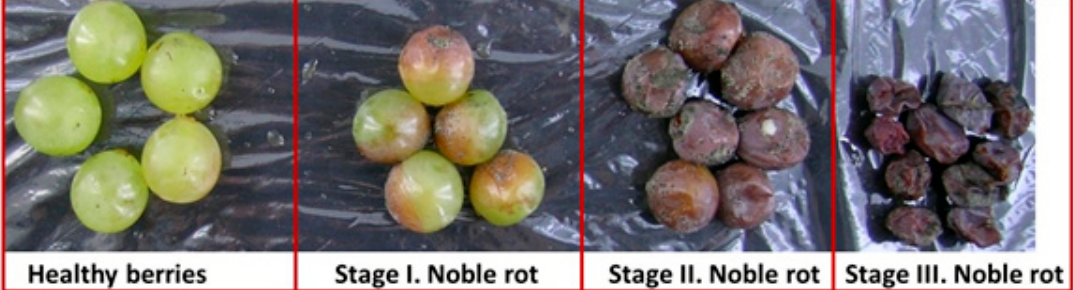
Figure 1. Healthy and botrytized Vitis vinifera cv. Furmint berries authentically represent samples used in this work. Besides healthy berries, three successive stages of noble rot were defined.